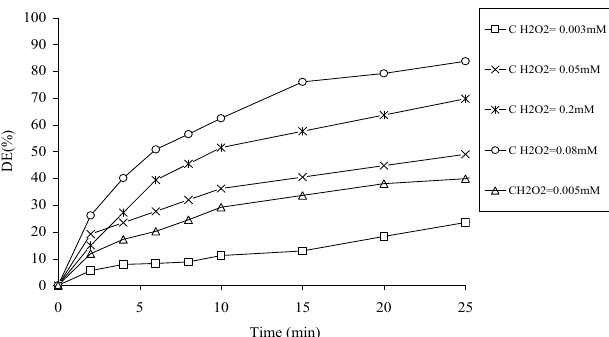
Fig. 5: Effet of initial H O concentration on NBB oxidation (pH=3, [C 2 2 Figure5: Effet of initial H 2 O 2 concentration on NBB oxidation (pH=3, [C i ]= 30mg/L, catalyst mass=0.005g)